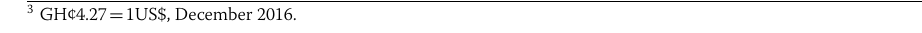
SD standard deviation, GH¢ Ghana’s